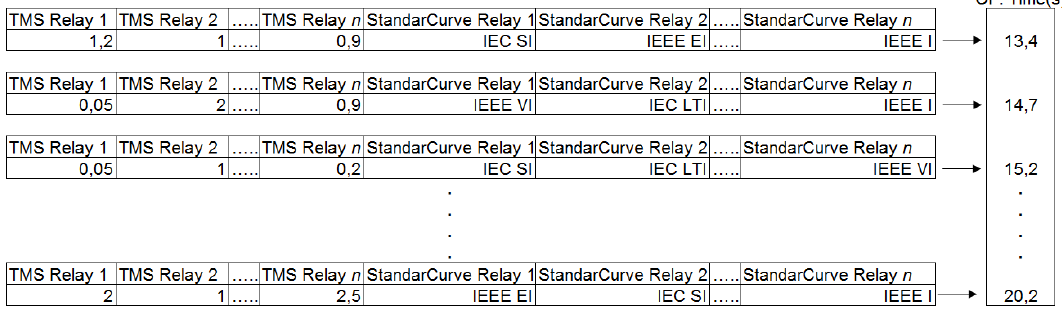
Figure 2. Fitness evaluation.